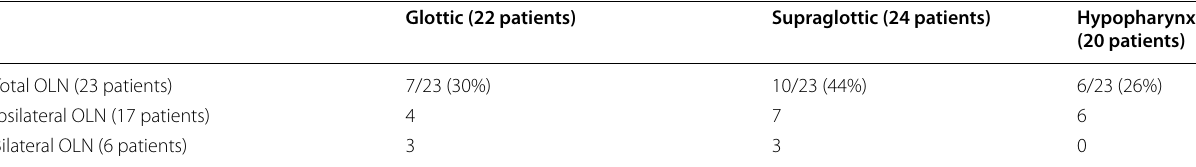
Table 2 Distribution of occult lymph node metastases in primary (pharyngo)laryngectomy